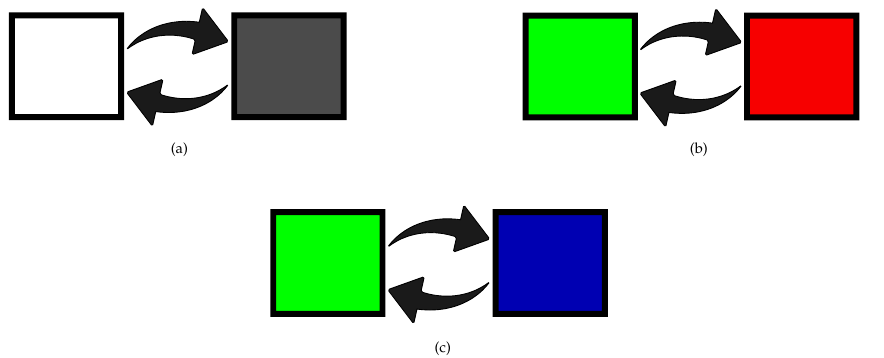
Figure 2. Visual stimulation used for the experiments: ( a ) Luminance stimulus (white, W); ( b ) green-red (G-R) stimulus; ( c ) green-blue (G-B)